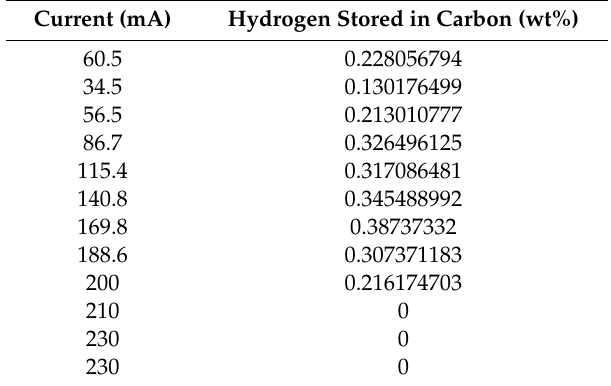
Figure 16. Graph showing relation between wt% of hydrogen stored in carbon and current during charging of modified unitized regenerative fuel cell (URFC) or proton battery. Table 11. X and Y axis variable values of the active points shown in Figure 16.